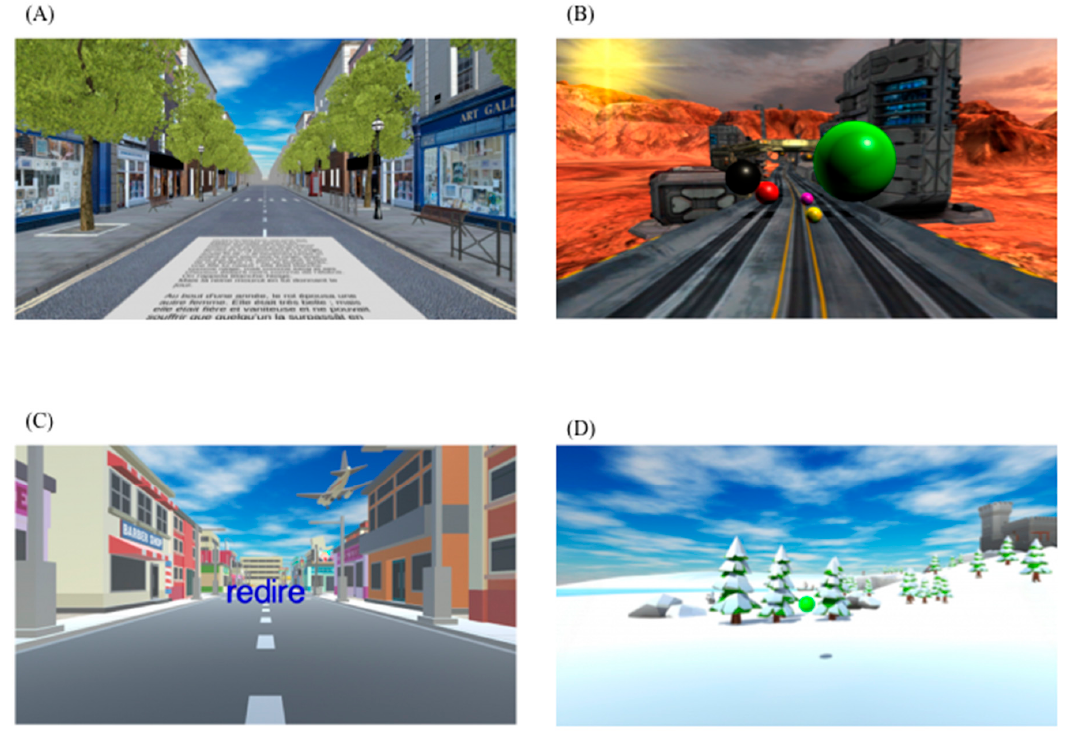
Figure 2. Example of MoveR exercises elicited: ( A ) Read in motion; ( B ) Battle race; ( C ) Jamp in words; ( D ) Vergence movements.